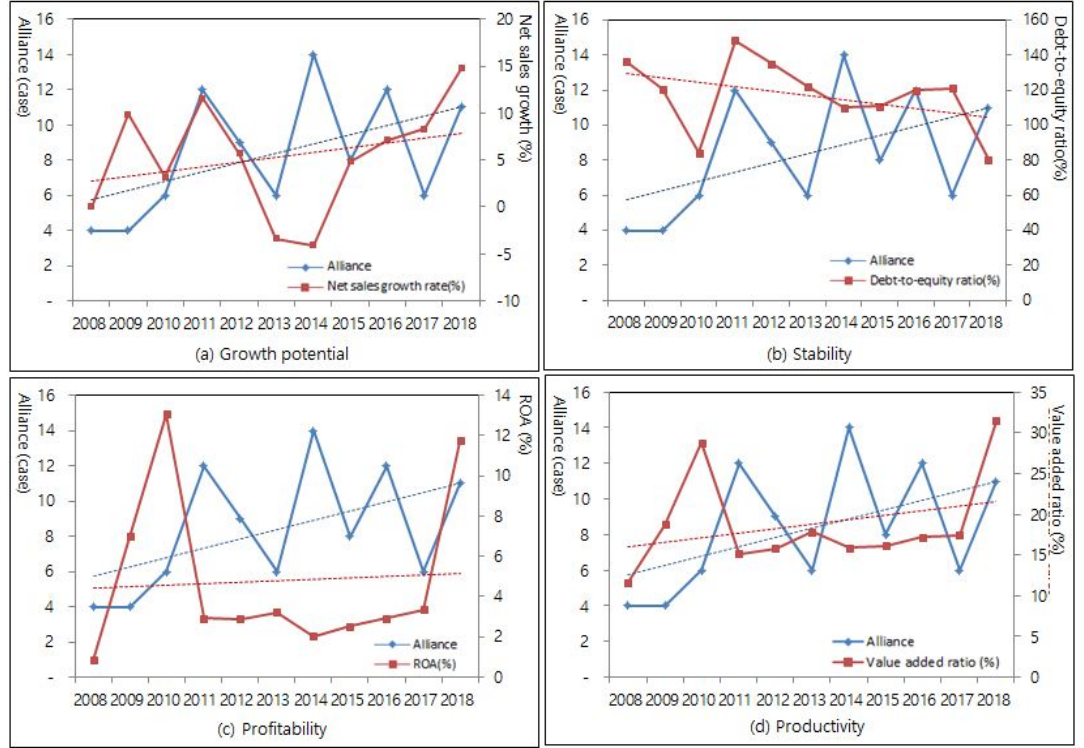
Figure 2. Analysis of CJ’s financial ratio.